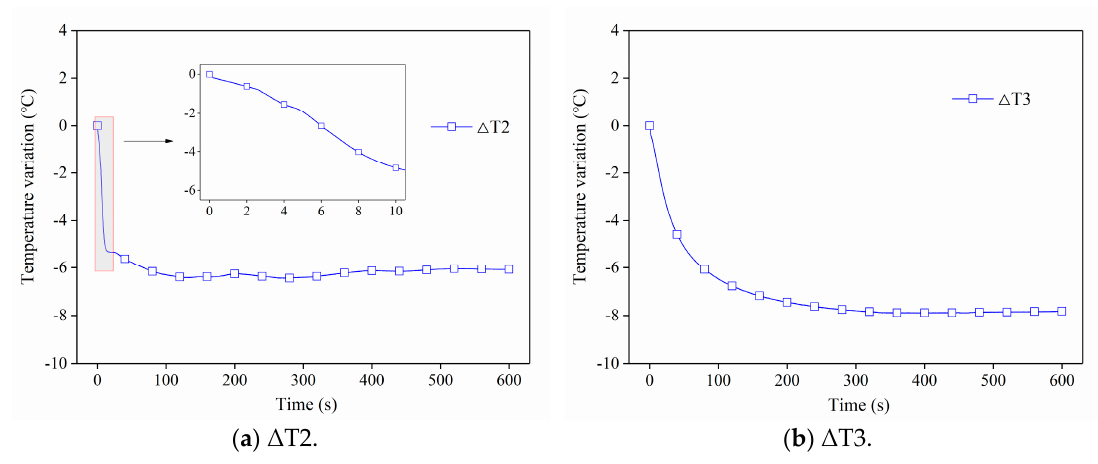
Figure 6. Pictures of the outburst observed at different times.